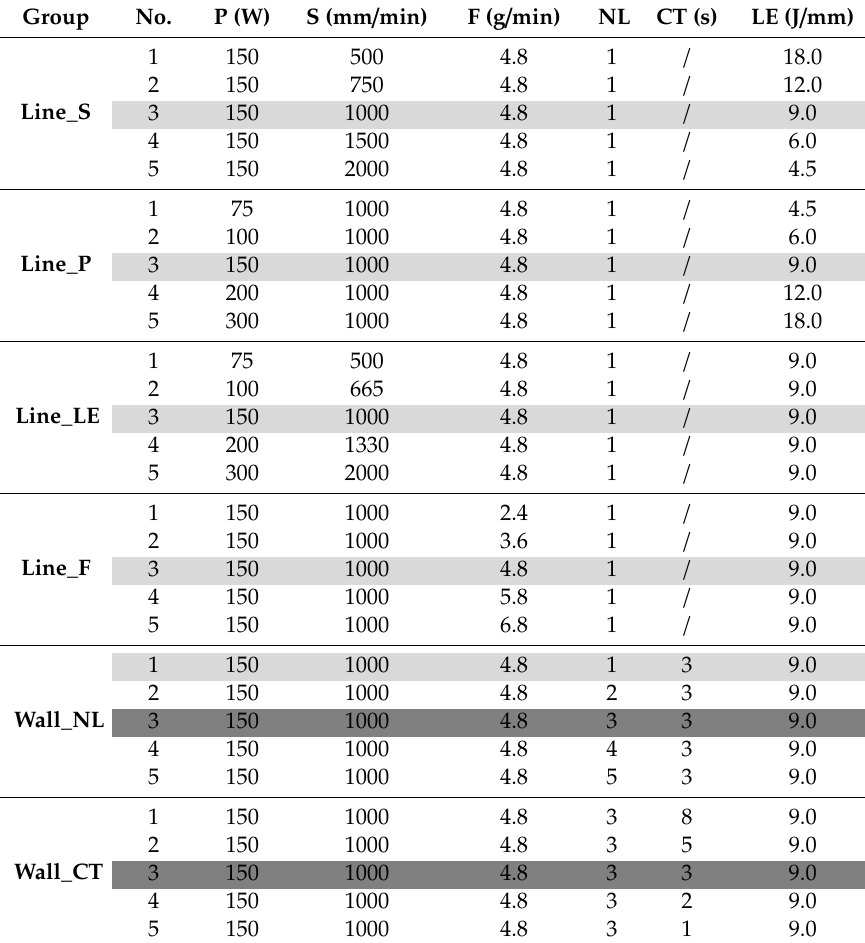
Table 1. Parameters used for all